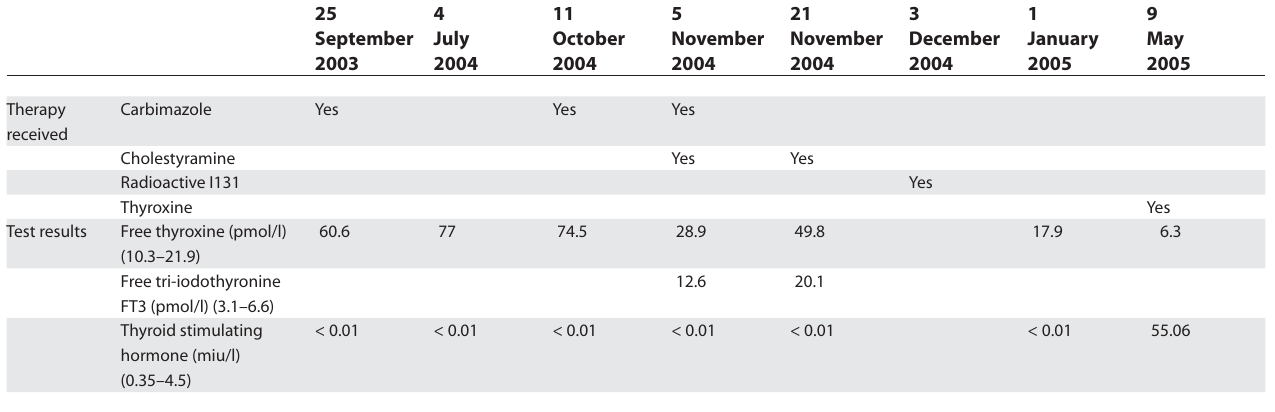
Table 1. Thyroid Function Test Results and Dates Performed with Therapy Received